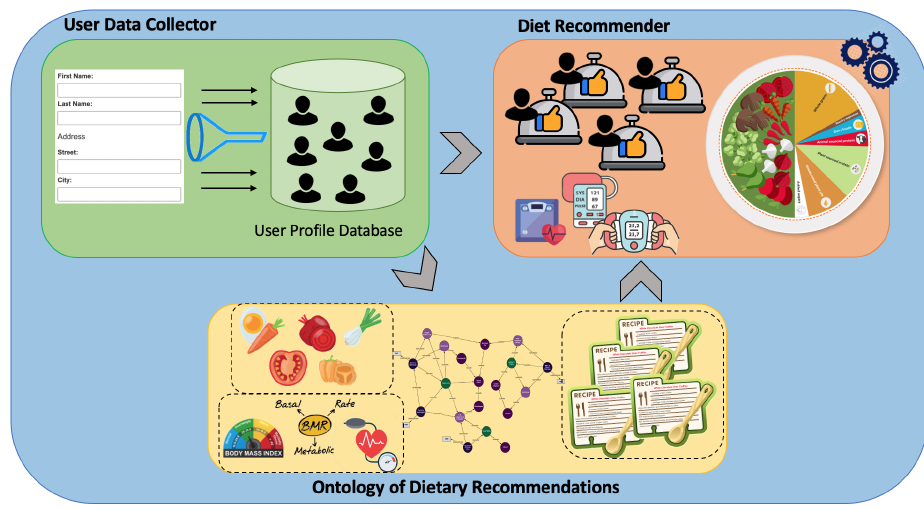
Figure 1. Architecture of the